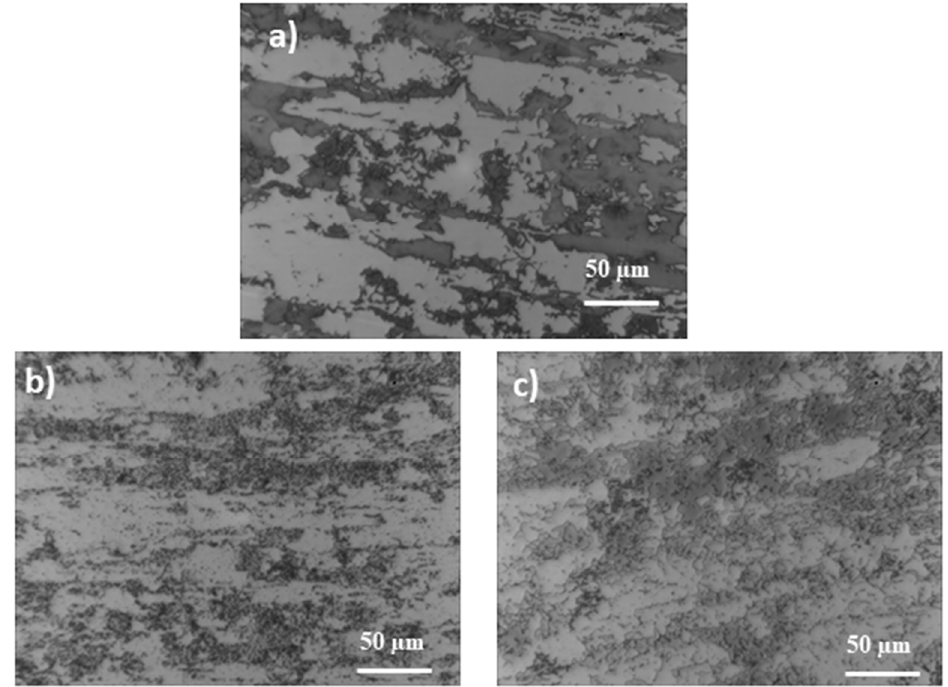
Figure 3. Microstructure of 1.4501 steel: ( a ) before annealing, ( b ) after annealing at 600 °C, ( c ) after annealing at 800 °C.